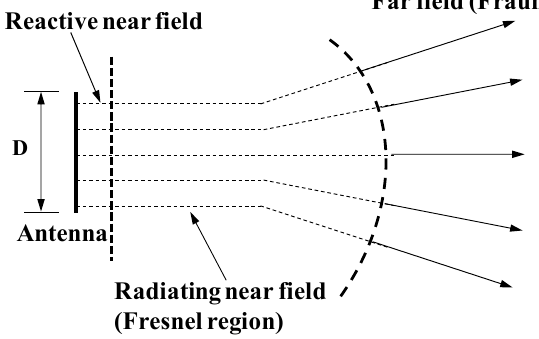
Figure 1. Field characteristic of antenna.